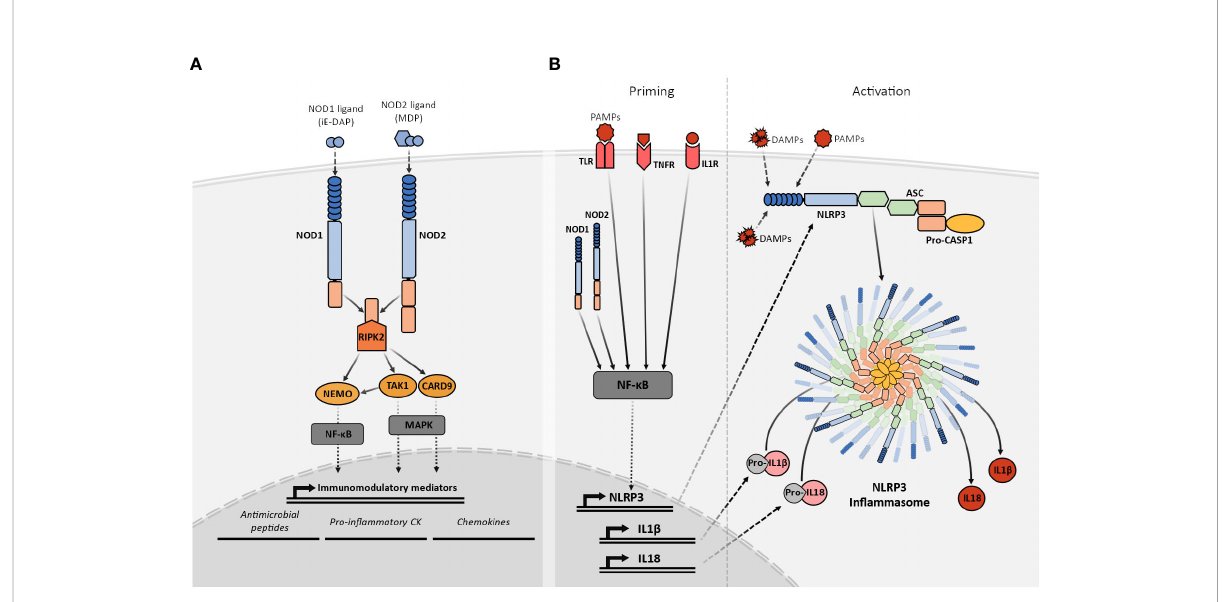
FIGURE 2 Simpli fi ed representation of the NOD1, NOD2, and NLRP3 signaling pathways. (A) Recognition of their speci fi c PGN fragments agonists through their LRR domains activates the NOD1 and NOD2 receptors. Their activation facilitates the recruitment of RIPK2 that subsequently interacts with TAK1 or NEMO triggering the NF- k B or MAPK pathways. The NF- k B and MAPK pathways, stimulate the transcriptional upregulation of different types of immunomodulatory mediators such as antimicrobial peptides, proin fl ammatory cytokines and chemokines. (B) NLRP3 activation requires two signals. The priming (left) is provided by MAMPs, DAMPs, or pro-in fl ammatory cytokines leading to the transcriptional upregulation of NLRP3, other in fl ammasome components, pro-IL1 b and pro-IL18 through NF- k B signaling. The activation signal (right) is provided by any of the numerous MAMPs or DAMPs capable of NLRP3 activation such as ATP, particulates, and crystals causing the NLRP3 in fl ammasome complex assembly and subsequent cleavage of pro-IL1 b and pro-IL18 into their mature forms by active